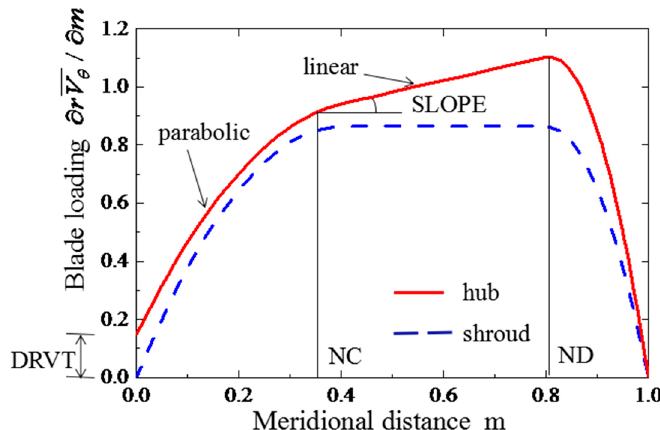
Figure 5. Blade loading distributions.